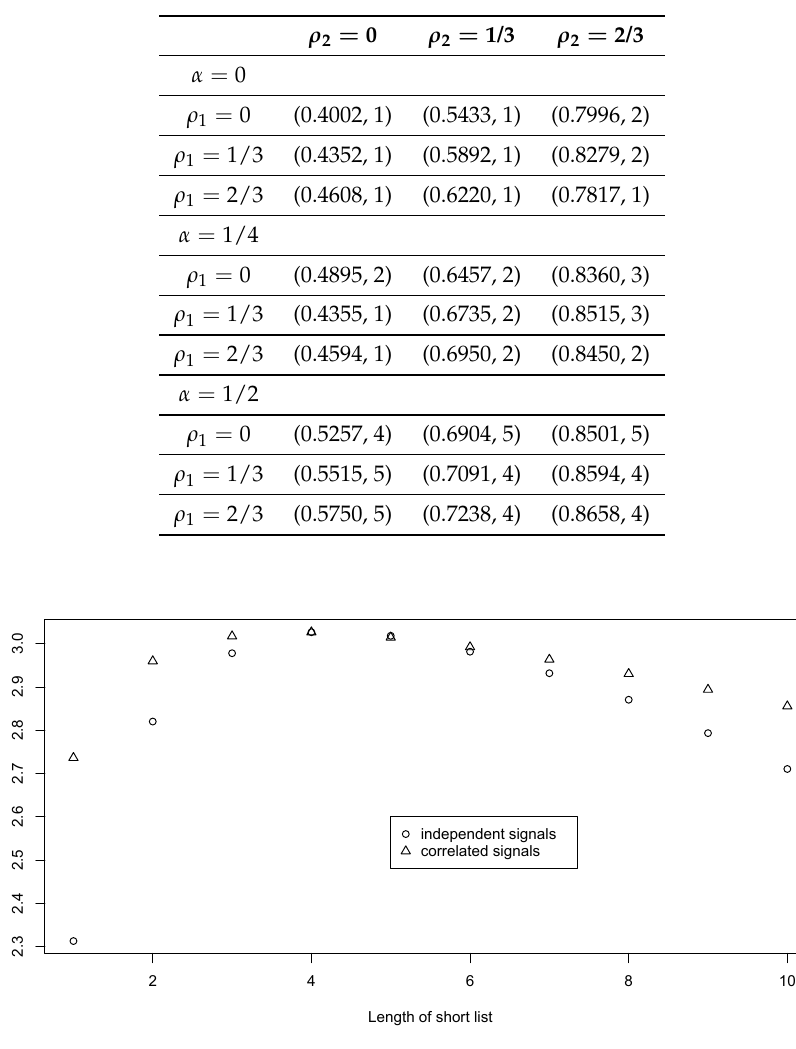
Table 4. Effect of the correlation structure on the effIciency and equilibrium length of the short list in games where r = σ 1 = σ 2 = 1 (the first value in each cell gives the efficiency and the second the empirically derived equilibrium length of the short list). The efficiency of the game-theoretic search procedure is increasing in the good will between the players and, in particular, the coherence of their preferences.